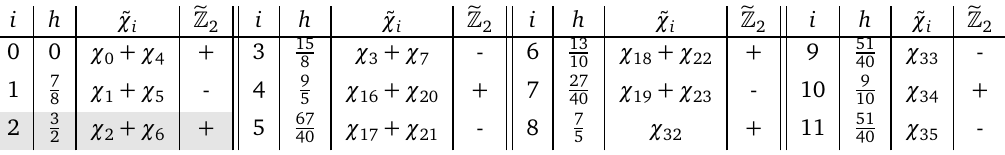
WZW model (see table 22). We highlight 2